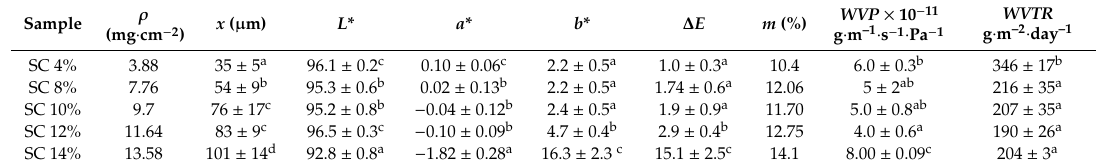
Table 2. Surface density ( ρ ), thickness ( x ), colorimetric parameters ( L *, a *, b *, ∆ E ), residual moisture content ( m ), water vapor permeability ( WVP ), and water vapor transmission rate ( WVTR ) of the SC-based films.